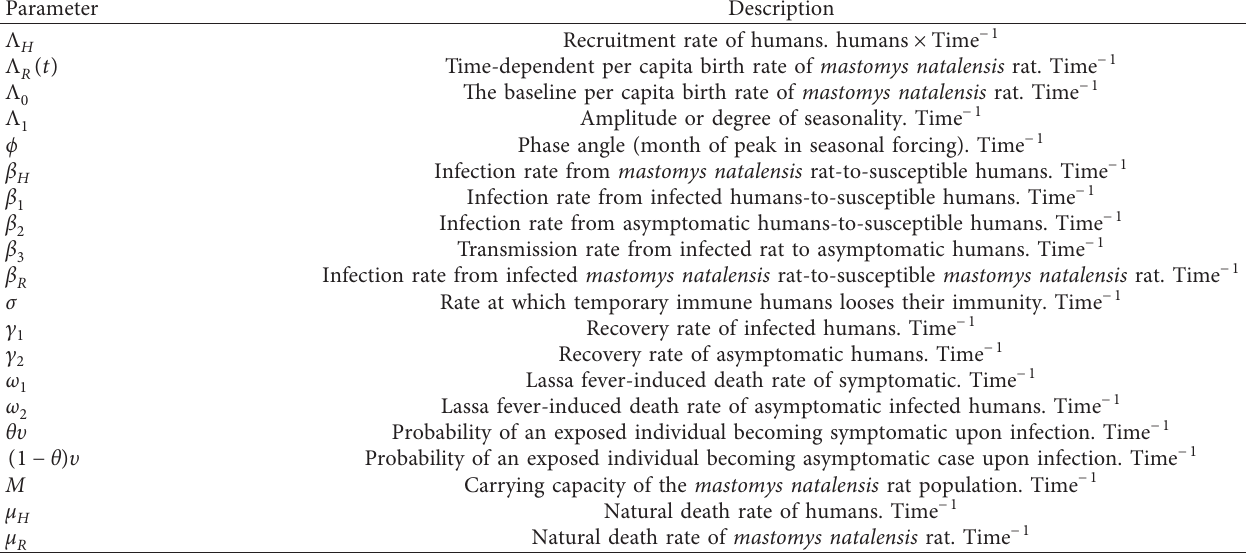
Table 2: Table showing parameters of the Lassa fever model.